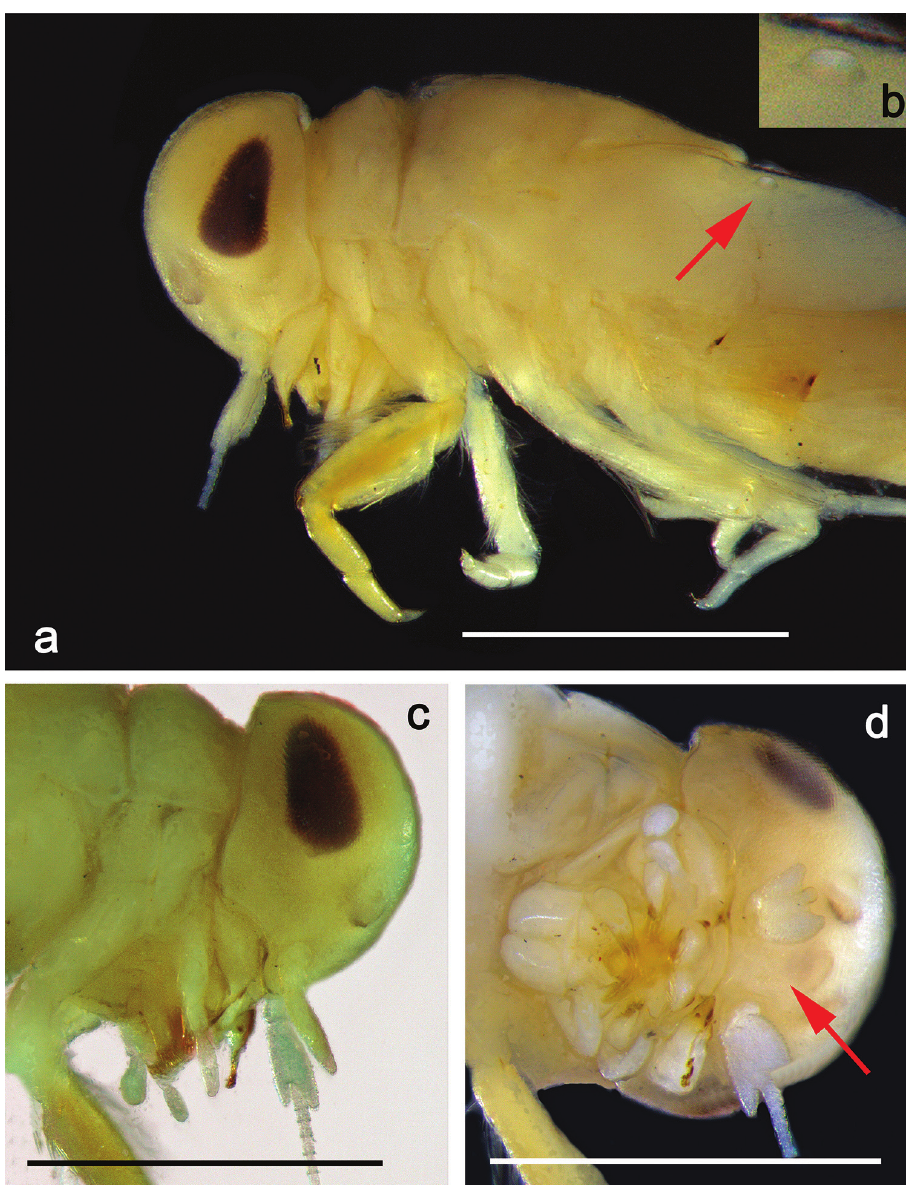
Figure 2. Pedicelliops capillifer gen. et sp. nov., larva morphology a head and thorax, lateral view b pro- tuberance on fore protopteron c head, lateral view d head, ventral view (arrow: carina). Scale bars: 1